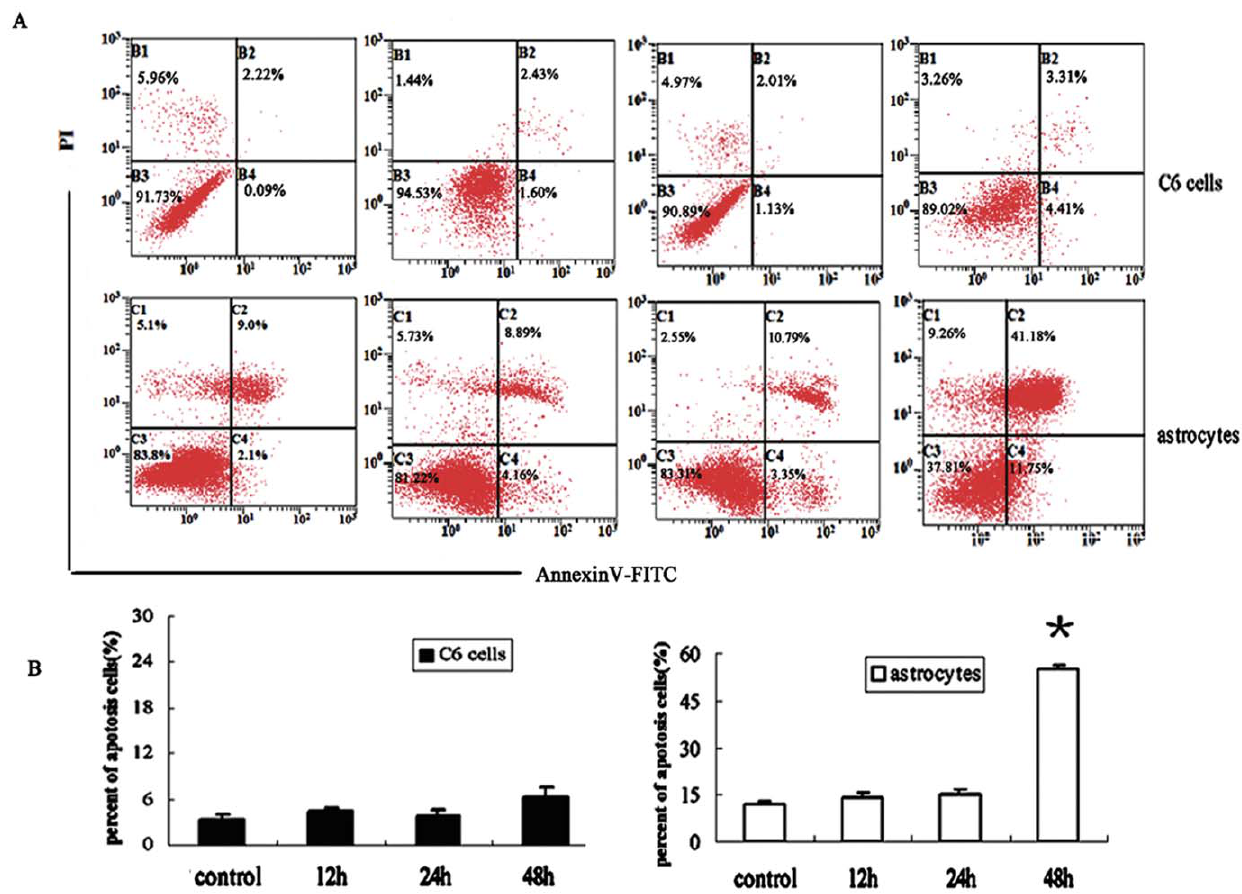
Figure 4. The apoptosis of astrocytes was induced after 48 h exposure. (A) Apoptosis of astrocytes and C6 cells was detected by FITC- conjugated Annexin-V/PI assay after exposure for 12 h, 24 h, or 48 h. Apoptosis of astrocytes was significantly induced by 48 h exposure, and the percent of apoptotic cells increased to about 50%, more than 3 times than that of other groups. (B)Statistical analysis for the percent of apoptosis cells in different groups. The data represent the mean 6 SEM from three experiments. *P , 0.05 as compared with unexposed groups.